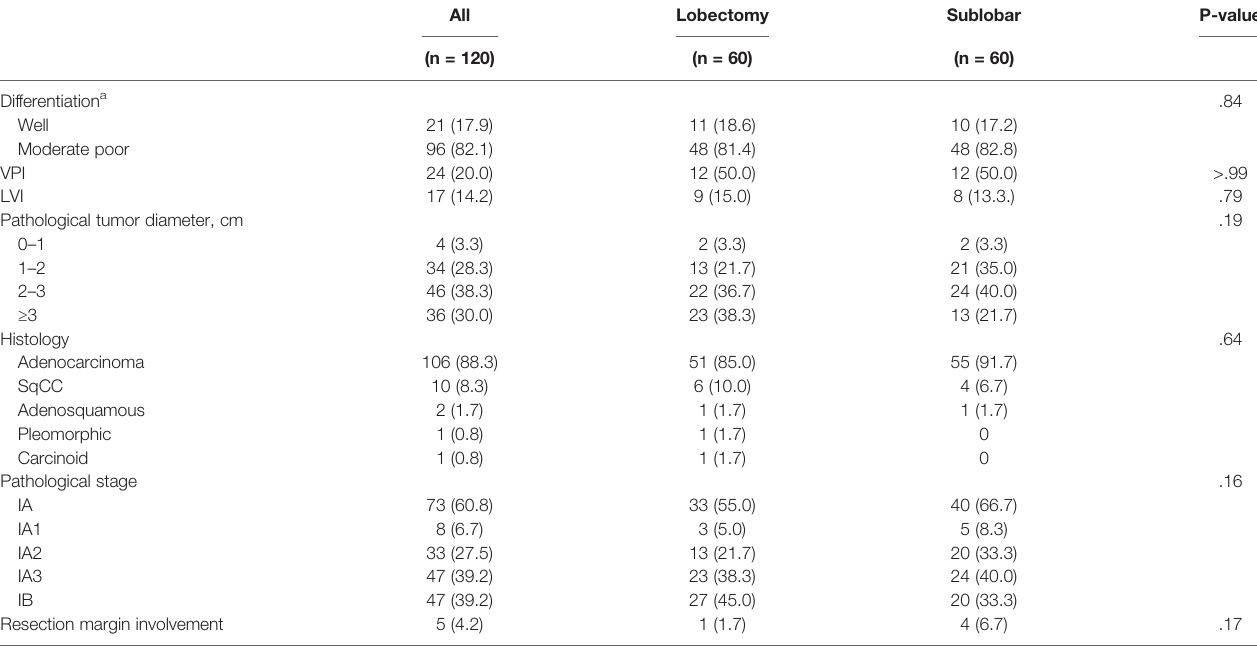
TABLE 2 | Pathological features after propensity score matching.